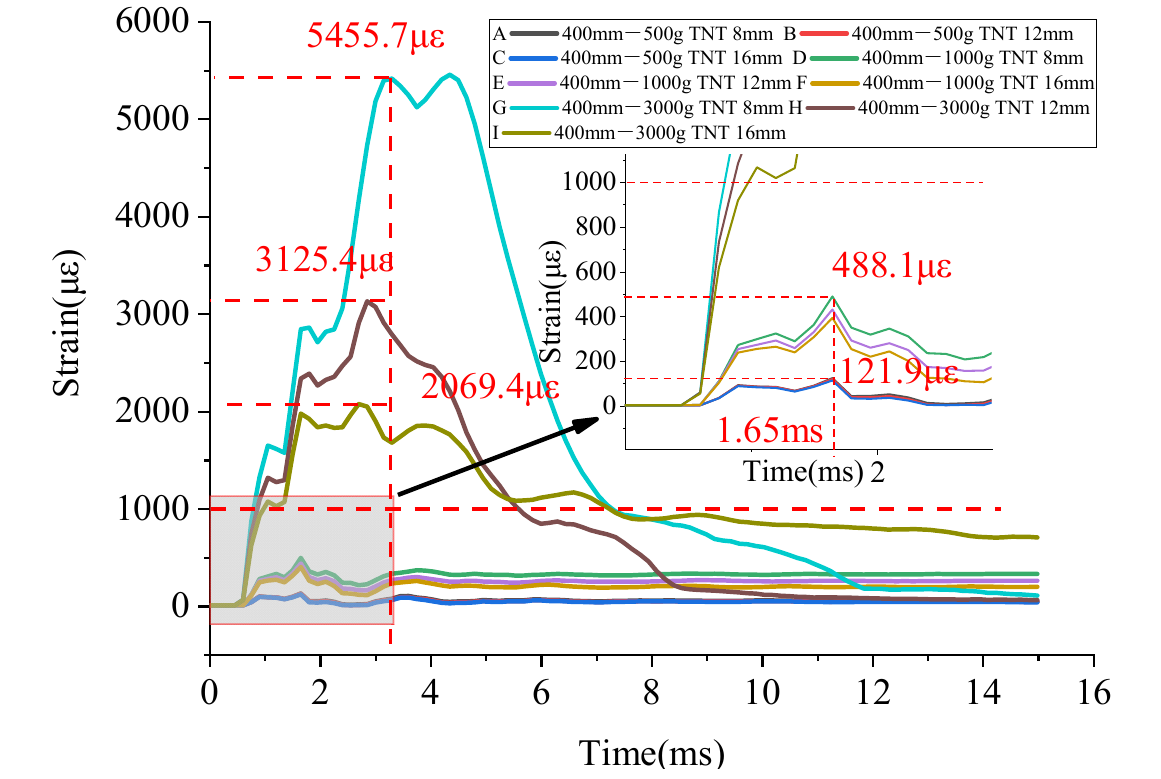
Figure 14. Time history curves of the strain of the BFRP bars at the vault under various working conditions with a standoff distance of 0.4 m.